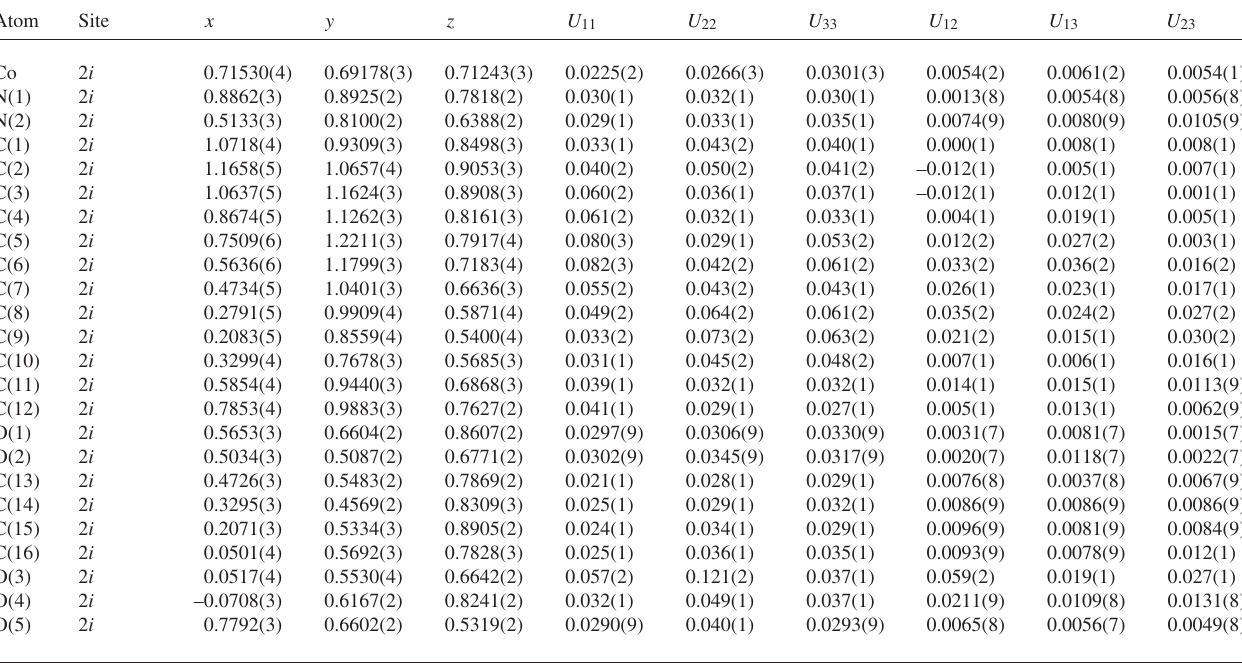
Table 3. Atomic coordinates and displacement parameters (in Å 2 )